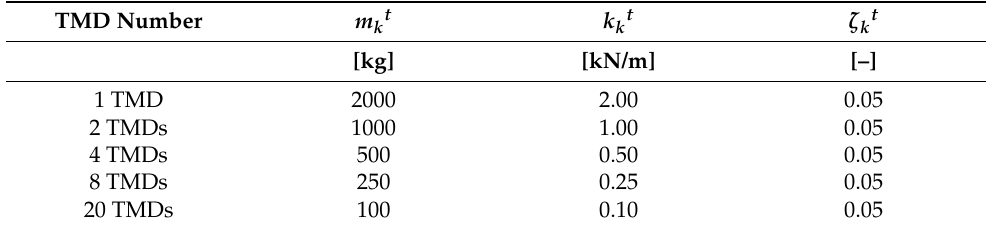
Figure 4. ( a ) Finite Element Method (FEM) model of the chimney and the first three mode shapes; ( b ) normalized eigenvectors for the first three eigenvalues. Table 1. Mass values for individual TMDs and k kt and ζ kt starting